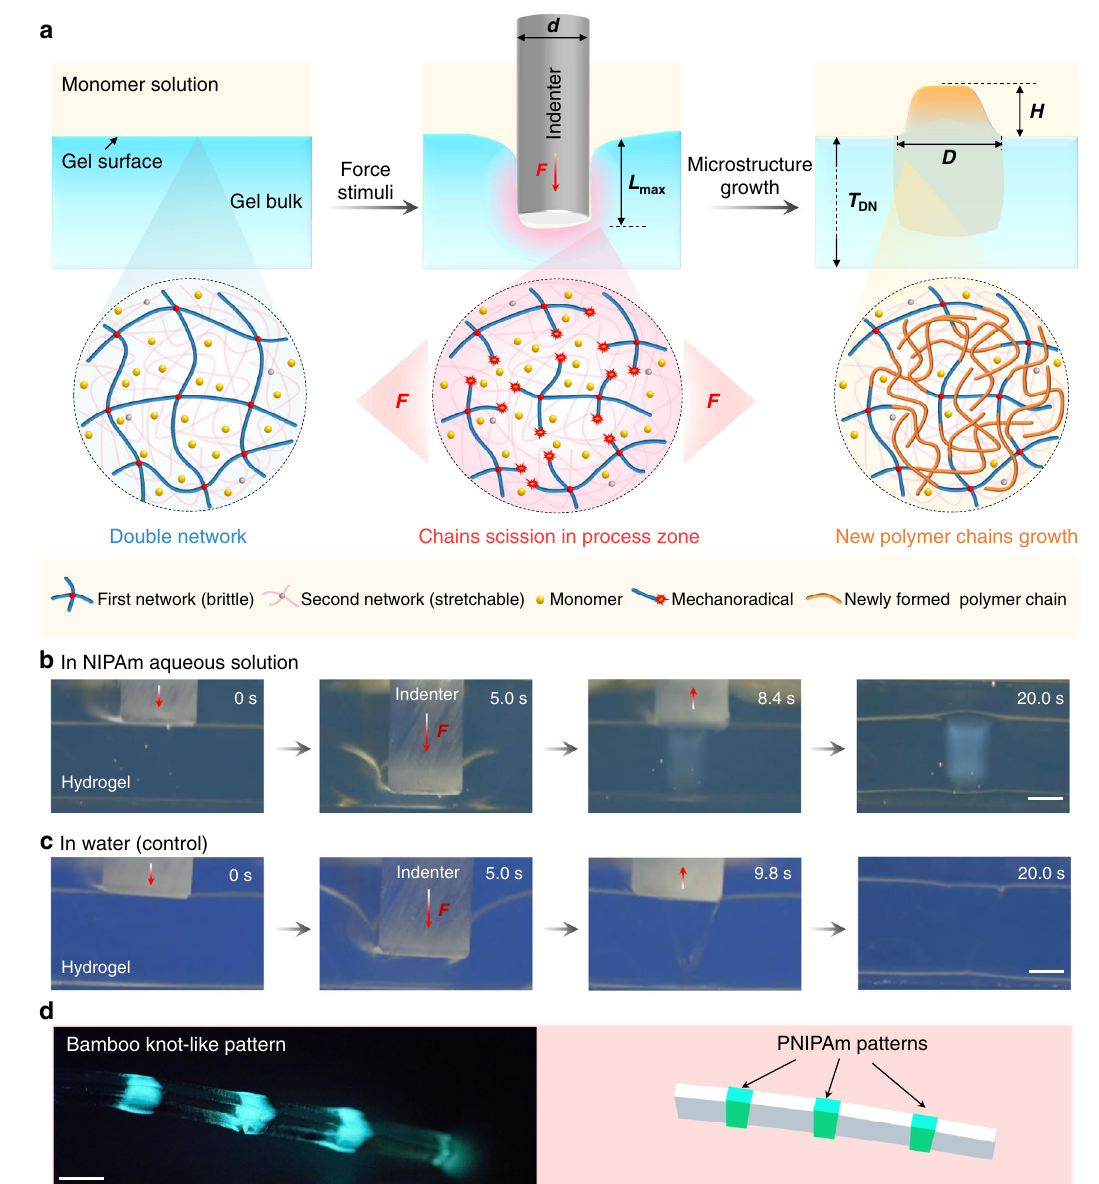
Fig. 1 | A mechanochemical strategy to rapidly grow microstructure on DN hydrogel surface. a Schematic illustration for rapid microstructure growth trig- gered by mechanical indentation under suf fi cient monomer supply. Molecular mechanism: the fi rst rigid network is locally broken by compression from the cylindricalmicro-indenter,whichgeneratesmechanoradicalsatthebrokenendsof the polymer strands in the indented zone (pink region); with the presence of monomers, the mechanoradicals initiate fast growth of new polymer chains; the new polymer causes excess swelling, resulting in the formation of topological